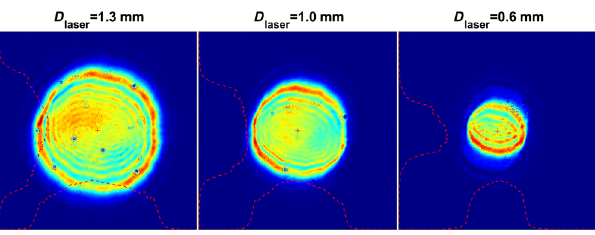
FIG. 8. Virtual cathode laser profiles with